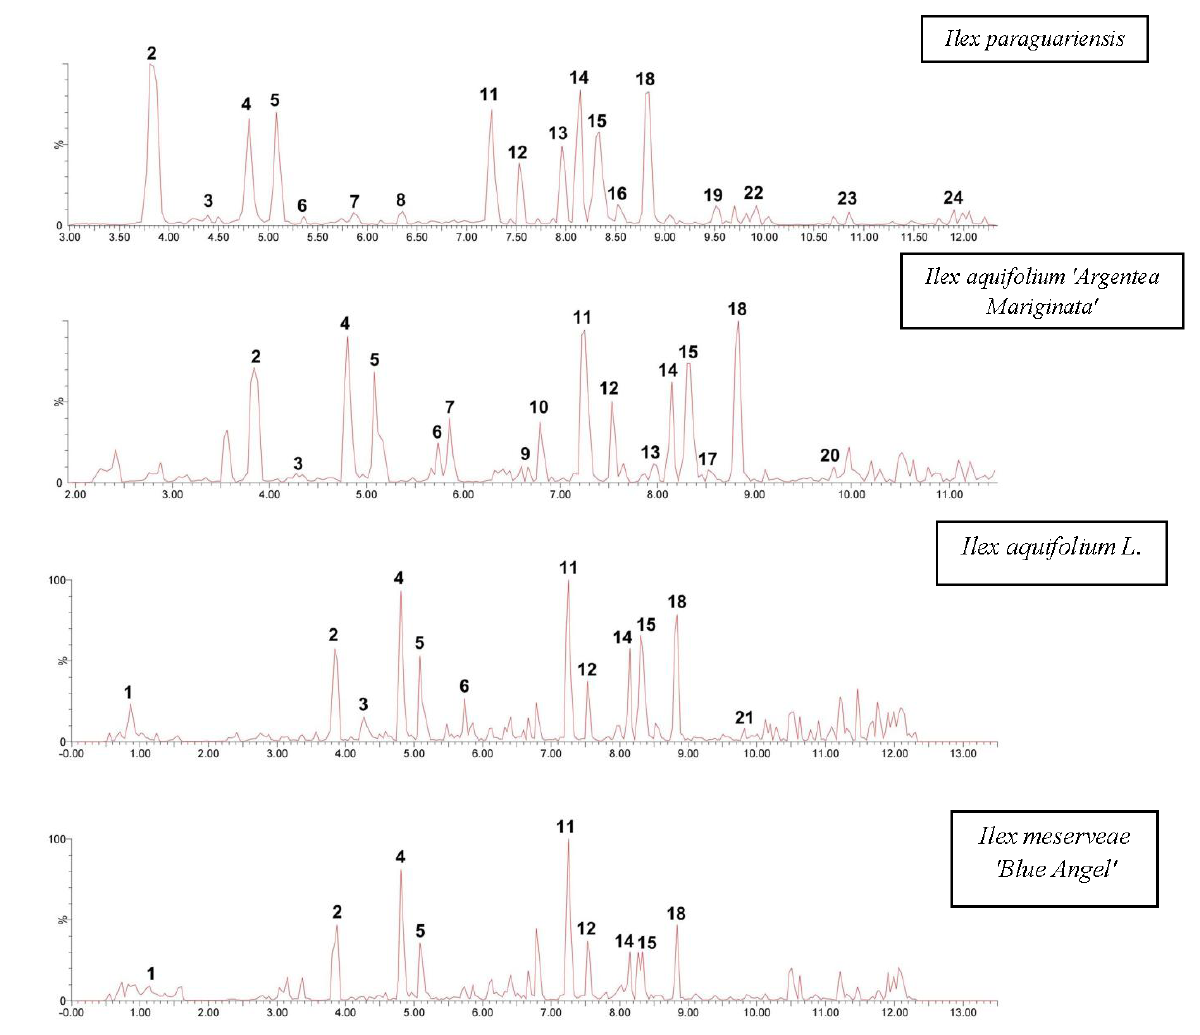
Figure 4: LC/MS chromatograms of Ilex sp . signal at